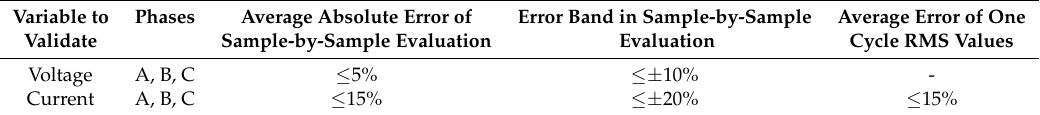
Table 2. Acceptable voltage and current deviation limits for validation of dynamic WT simulation models as part of the WPP commissioning process following the South African grid connection code. Variable